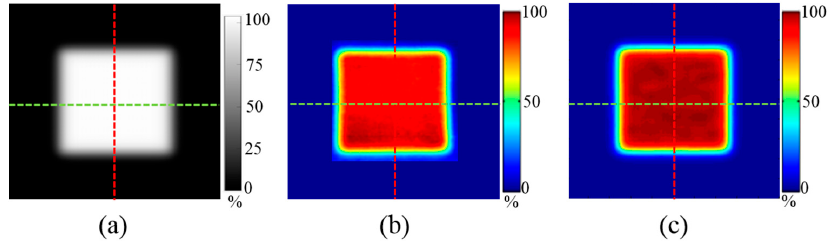
Figure 4. An example of measured 2D dose distributions using various dosimetric tools (Case 3 of the square-shaped field in Table 1). ( a ) MatriXX; ( b ) EBT3 film; ( c ) FORS.